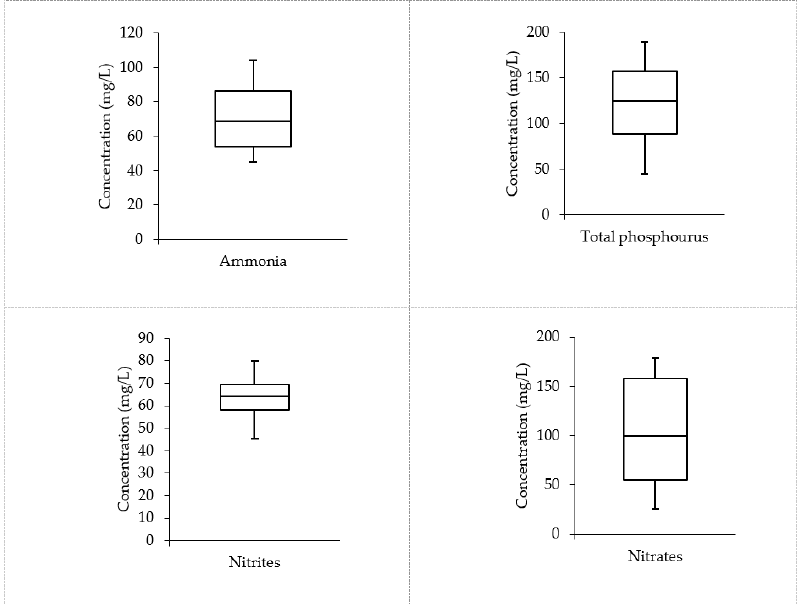
Figure 2. Box plots of raw